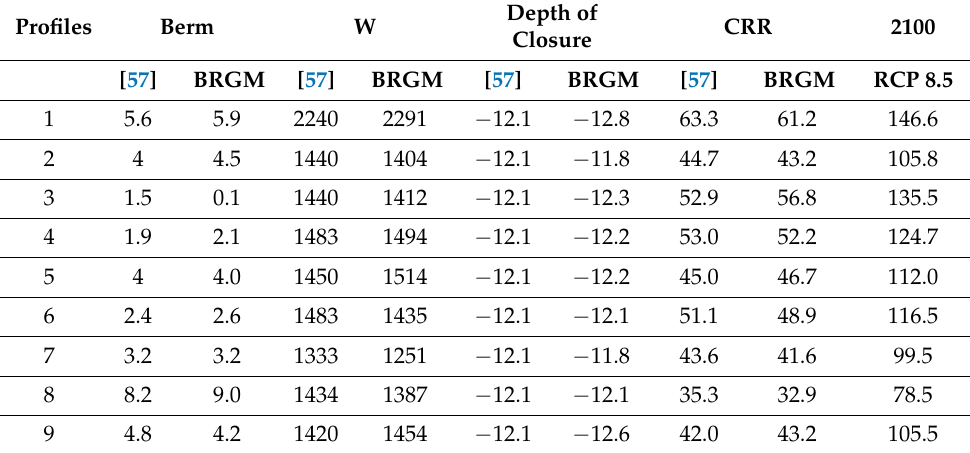
Figure 9. Correlation matrix of the coast section. ( a ) Area differences; ( b ) Kernel Density correlation matrix. ( c ) Deep AI image similarity API. ( d ) Resemble.js image similarity. The values of correlation are included in the squares. Table 3. Values of morphological variables obtained by [57] and in the present work. The coastline retreat results (CRR) in both situations are calculated using a sea-level rise (SLR) of 0.50 m. The 2100 RCP 8.5 AIS uses an SLR of 1.21 m. The units of the berm, profile length (W), and depth of closure are in meters